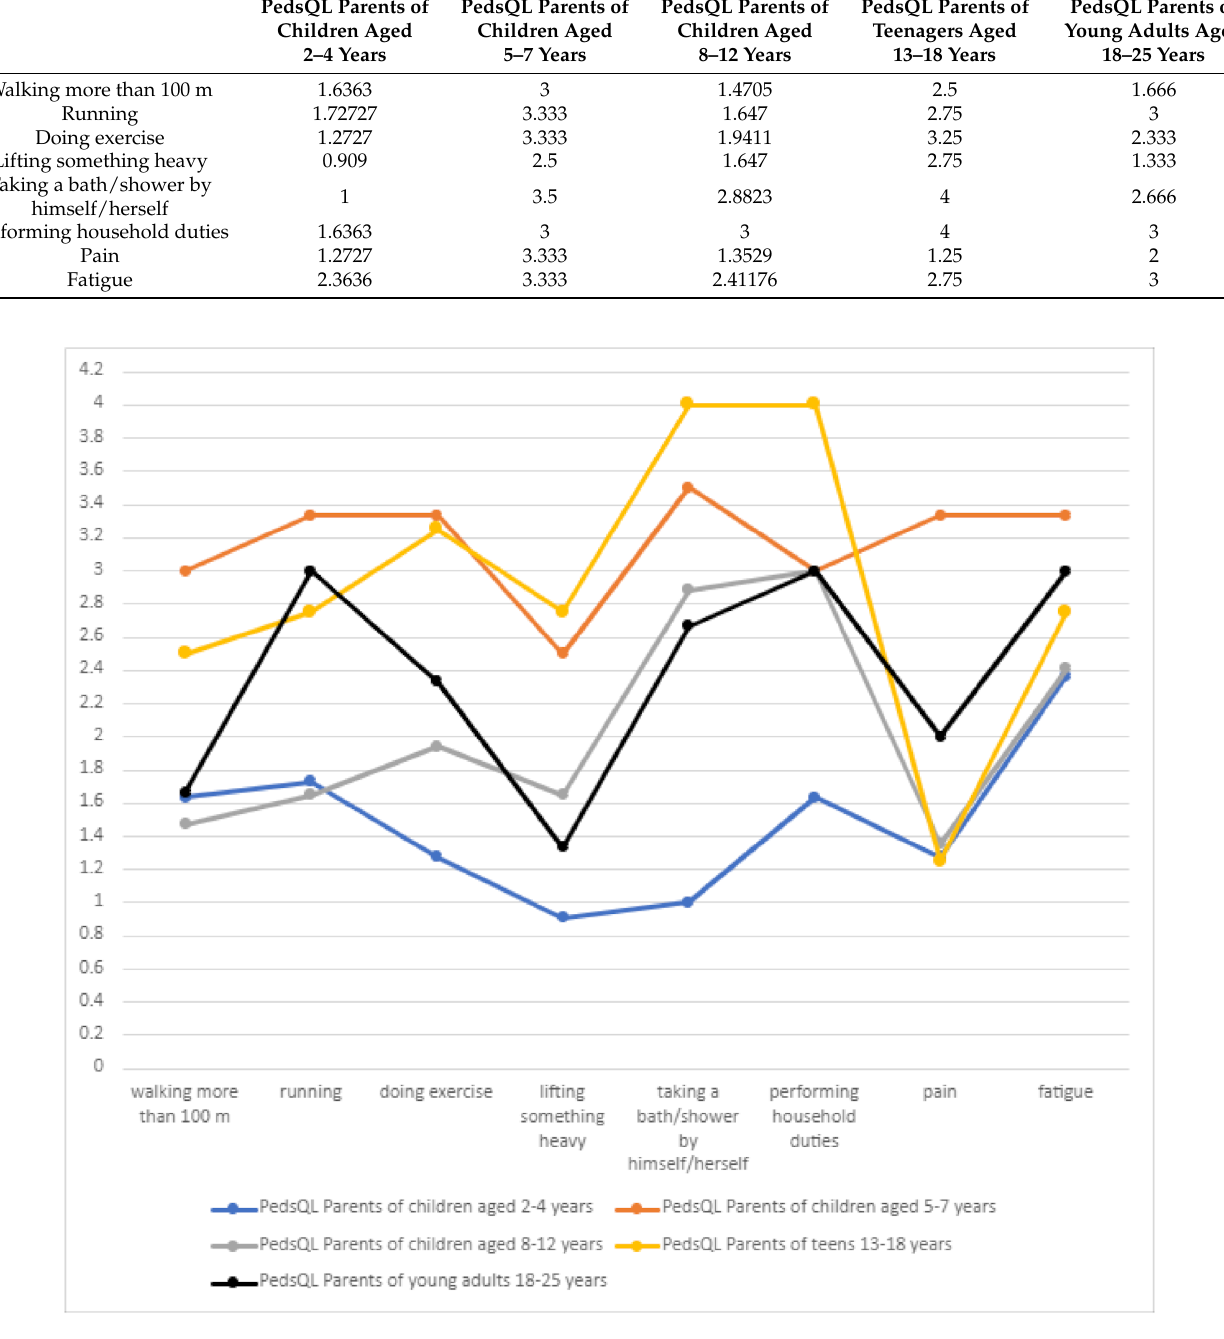
Figure 11. Physical functioning in children with Dravet